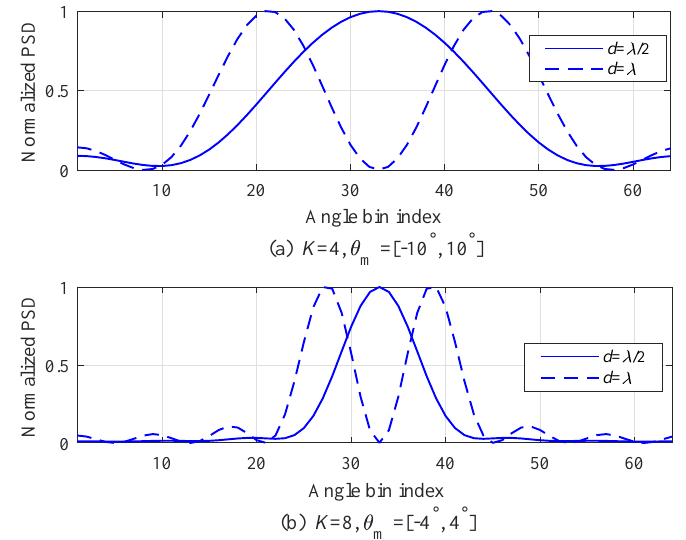
Figure 4. Normalized power spectral density (PSD) according to angle-bin